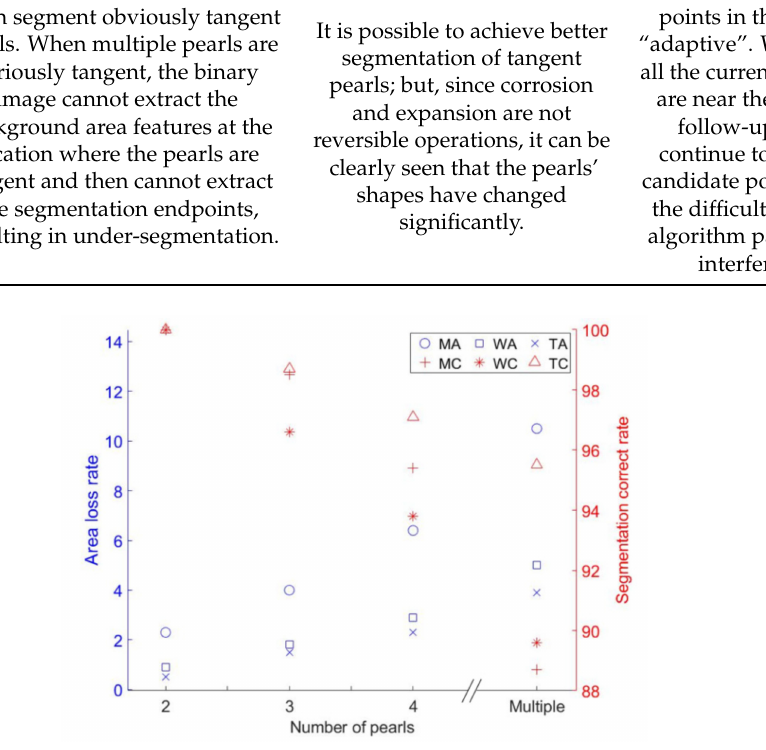
Figure 11. Comparison test statistical results of different segmentation